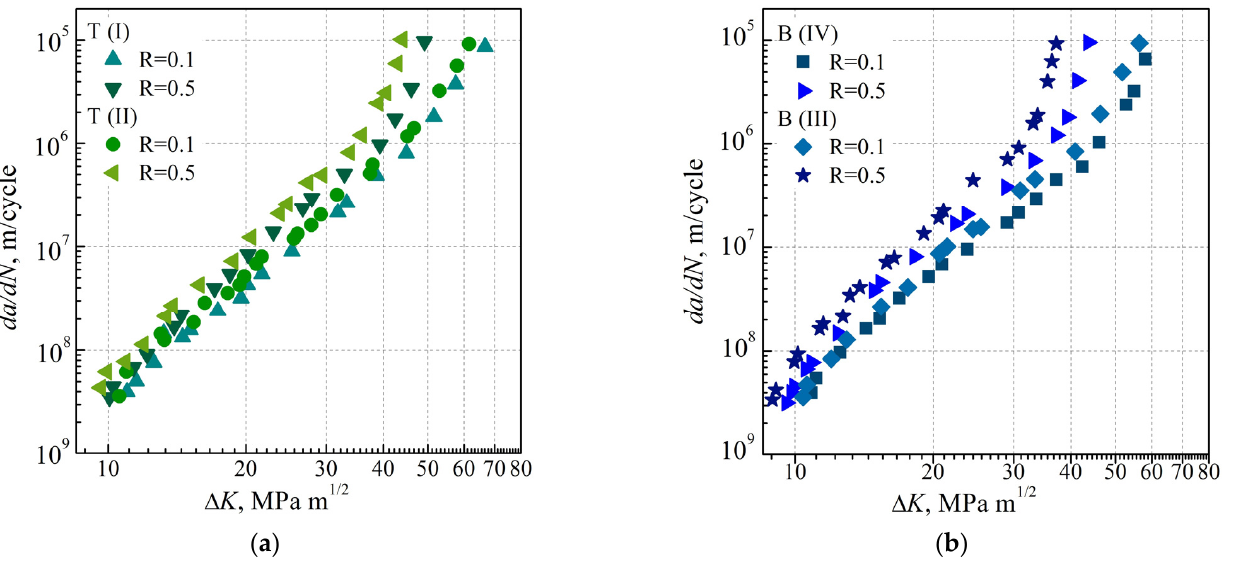
Figure 8. Dependences of the FCG rate on the SIF range ( da / dN — ∆ K ) obtained for 17H1S steel at values of the stress ratio of 0.1 and 0.5. Specimens of the steel were cut from ( a ) the upper T and ( b ) lower B parts of the LTO pipe in positions close to its outer ((I),(IV)) and inner ((II),(III)) surfaces.